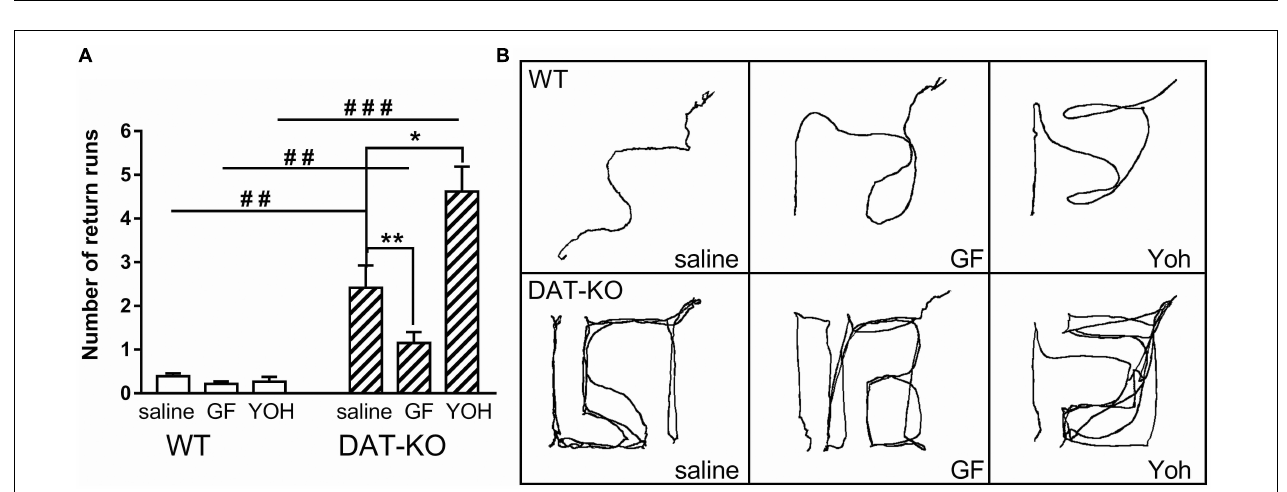
FIGURE 4 | Comparison of the number of return runs reflecting stereotypical (perseverative) patterns of activity (A) and examples of movement patterns (B) in WT and DAT-KO rats in Experiment 1 (saline injections), Experiment 2 (GF injections), and Experiment 3 (YOH injections); ### p < 0.001; ## p < 0.01; one-way Kruskal–Wallis test combined with Dunn’s multiple-comparison post hoc test; * p < 0.05; ** p < 0.01; Mann Whitney paired test; WT, wild-type; DAT-KO, dopamine transporter knockout rats.